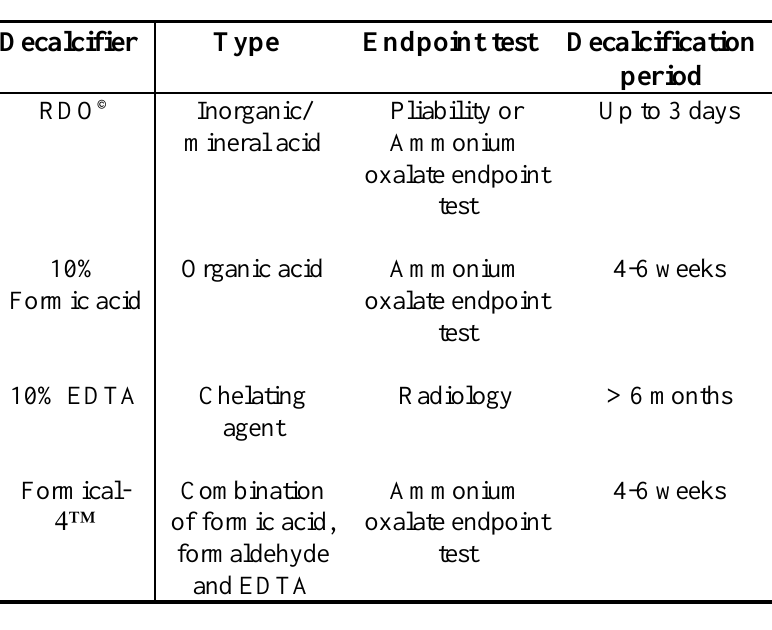
Table 1. Decalcifiers evaluated within the current